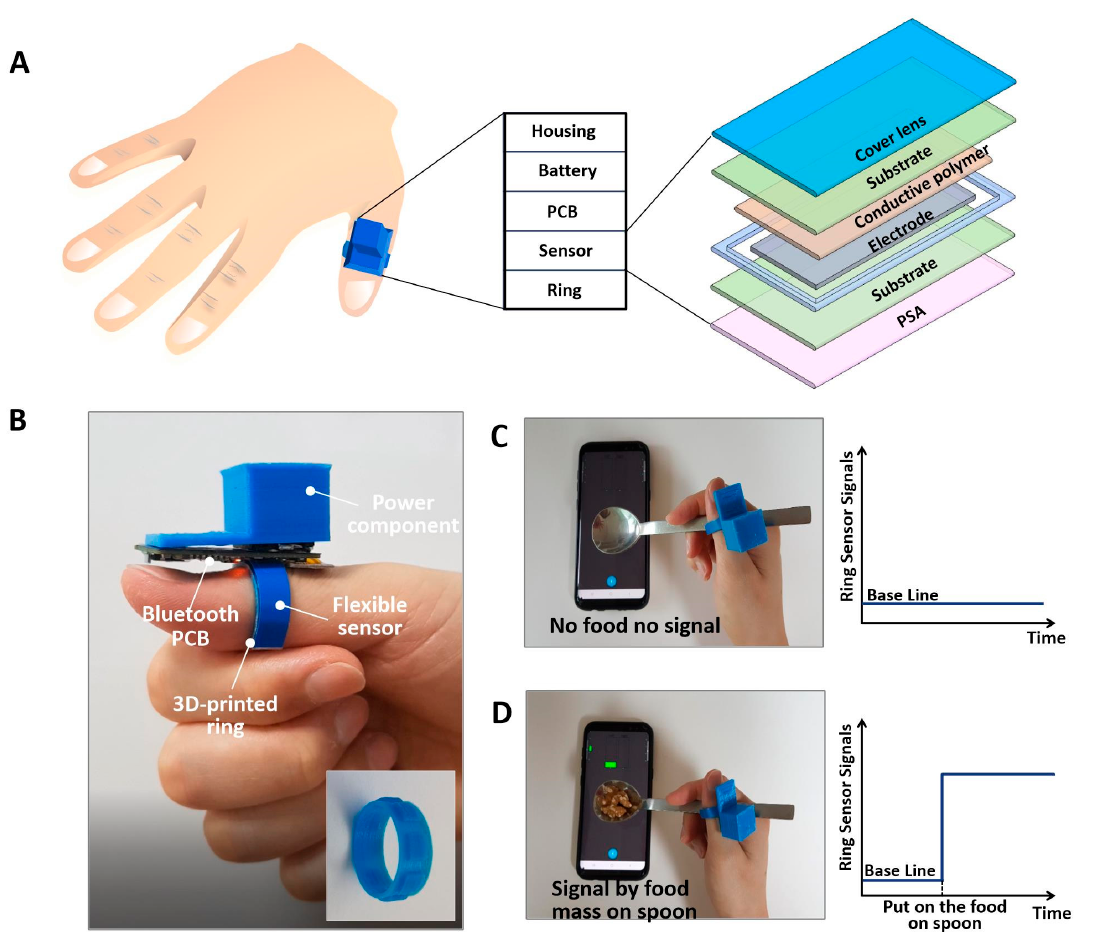
Figure 1. Schematic illustration and photograph of the ring-type biosensor for dietary monitoring via a smartphone. ( A ) Composition layer of ring sensing system: ring, sensor, printed circuit board, battery and housing, and flexible sensor: cover lens, substrate, conductive polymer, electrode, substrate, and pressure-sensitive adhesive. ( B ) Ring-type biosensing system mounted on the thumb and component unit: flexible tactile sensor, 3D-printed ring, power component and circuit board for wireless communication and battery. ( C ) Establishment of a baseline signal for a spoon with no food mass, taken using filtering. ( D ) Signal generated by food mass on the spoon.